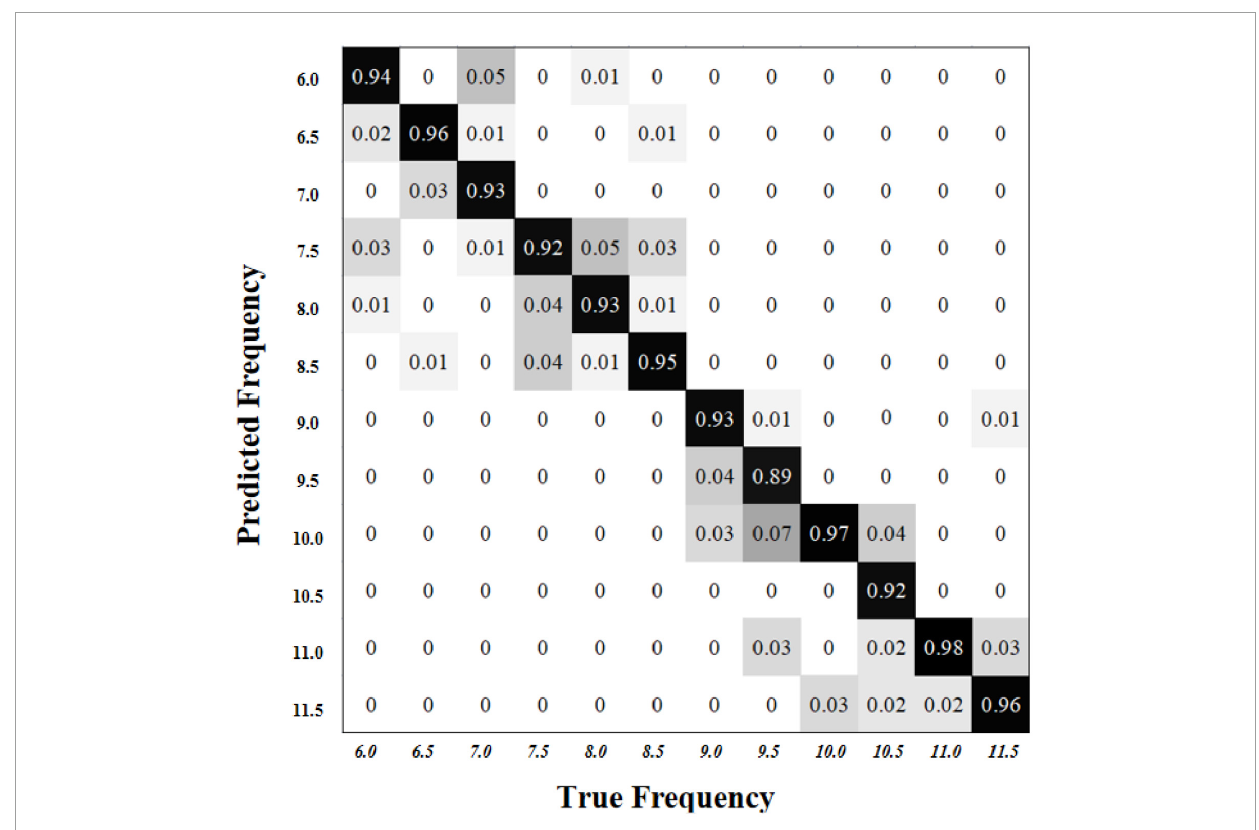
FIGURE7 The confusion matrix in the online experiments to compare the recognition accuracy of different targets.